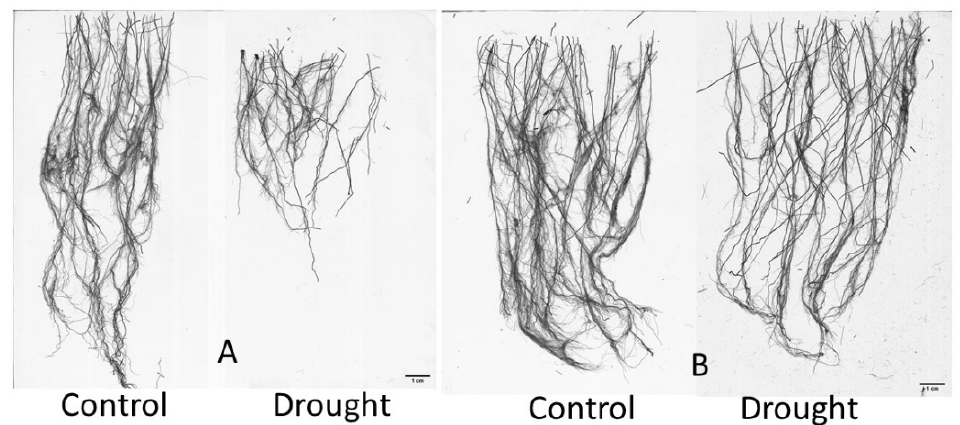
Figure 4. ( A ) Effect of drought on the root structures of drought-sensitive (IRRI 154) and ( B ) drought-tolerant (IR86126) rice genotypes; the drought-tolerant genotype shows more extensive root structure than the drought-sensitive rice genotype, analyzed after harvest using a WinRHIZO optical scanner and software system. Scale bar = 1 cm.